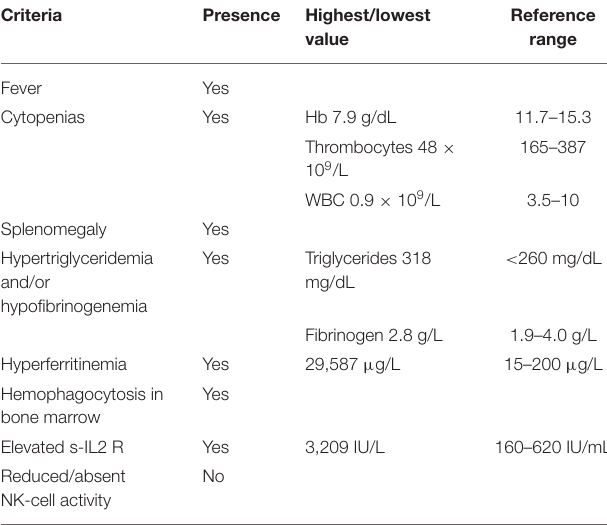
FIGURE 2 | Bone marrow biopsy and CT examination. Bone marrow biopsy from the patient demonstrating; (A) modest hypocellularity; (B) higher magnification demonstrating granuloma formation with inflammation; (C) macrophages with marked hemophagocytosis; (D) giant cells. (E) CT abdomen showing hepatosplenomegaly with “kissing sign”. TABLE 2 | HLH criteria met in the